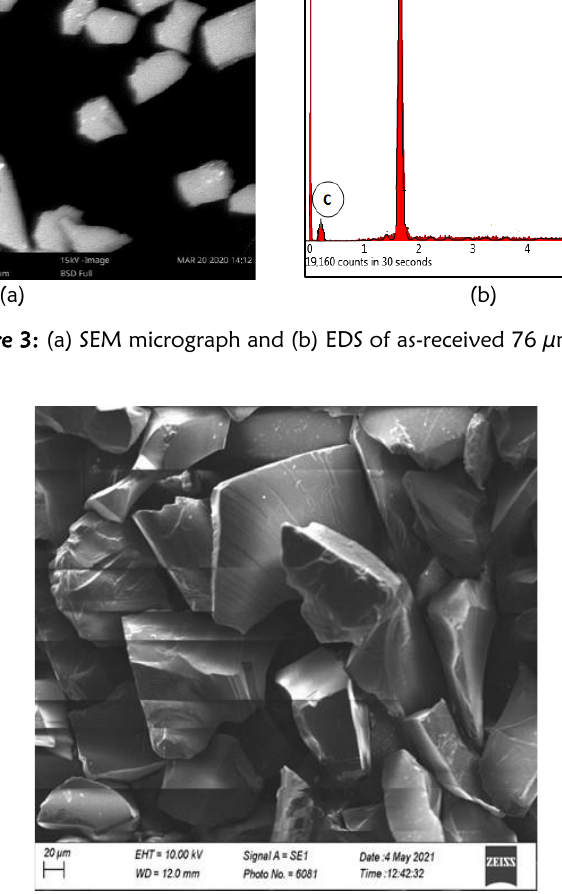
Figure 4: Surface morphology of 1100 °C pre-oxidized SiC